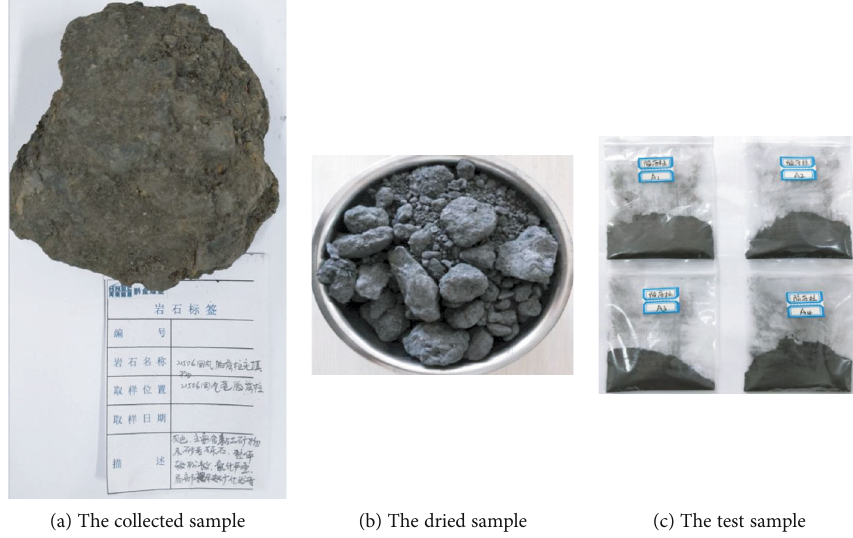
Figure 2: Mineral component of collapse column.